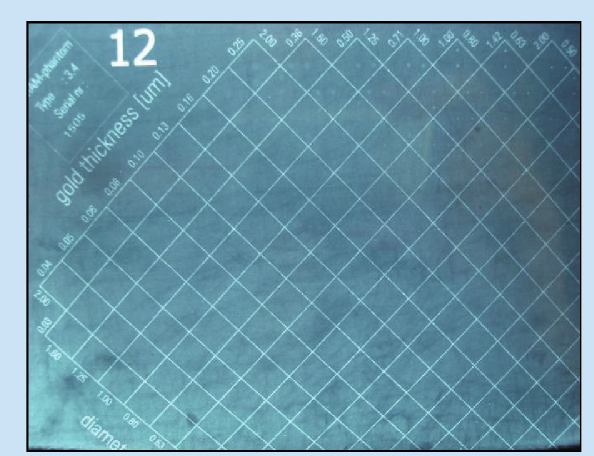
Fig. 2. CDMAM Superflab phantom image.